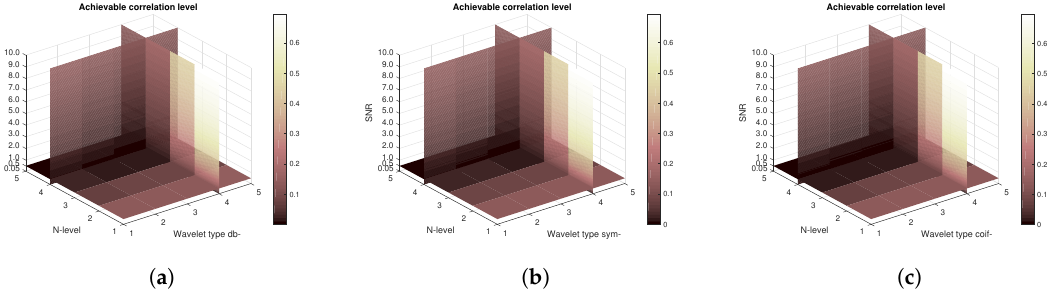
Figure 23. Mean achievable correlation levels of all EMG signal with use of three mother wavelet families—from left Daubechies ( a ), Symlet ( b ) and Coiflet ( c